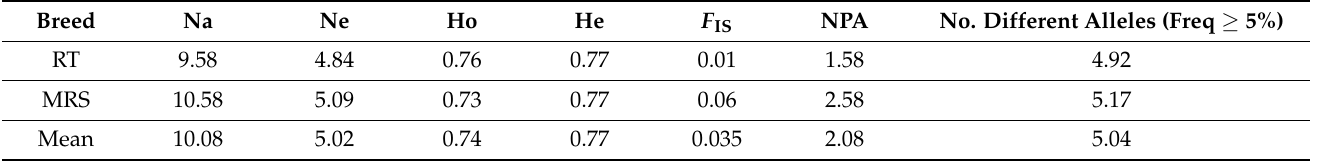
Table 3. Number of different alleles (Na), number of effective alleles (Ne), observed (Ho) and expected (He) heterozygosities, coefficient of inbreeding (F IS ), and number of alleles unique to a single population (NPA) in Rhodopean Tsigai (RT) and Middle Rhodopean Sheep